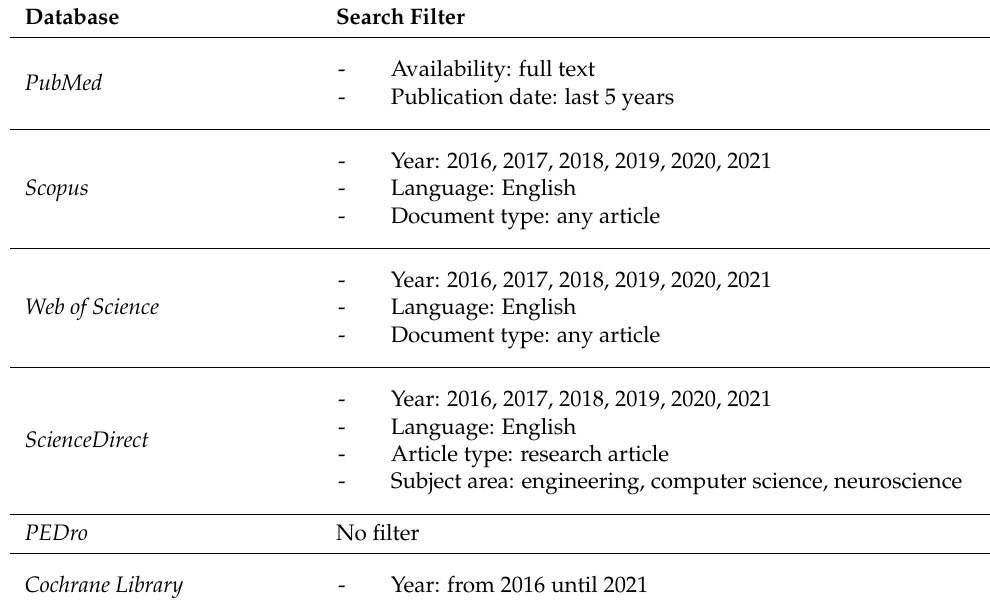
Table 1. Search filters in